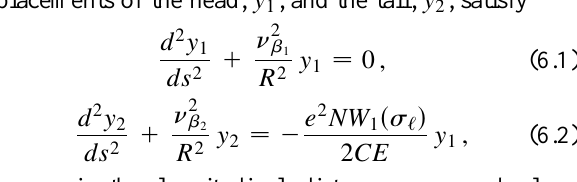
FIG. 13. The two-particle model, where the bunch is repre- sented by two macroparticles each carrying half the charge of the bunch separated by a distance ˆ z . displacements of the head, y 1 , and the tail, y 2 , satisfy